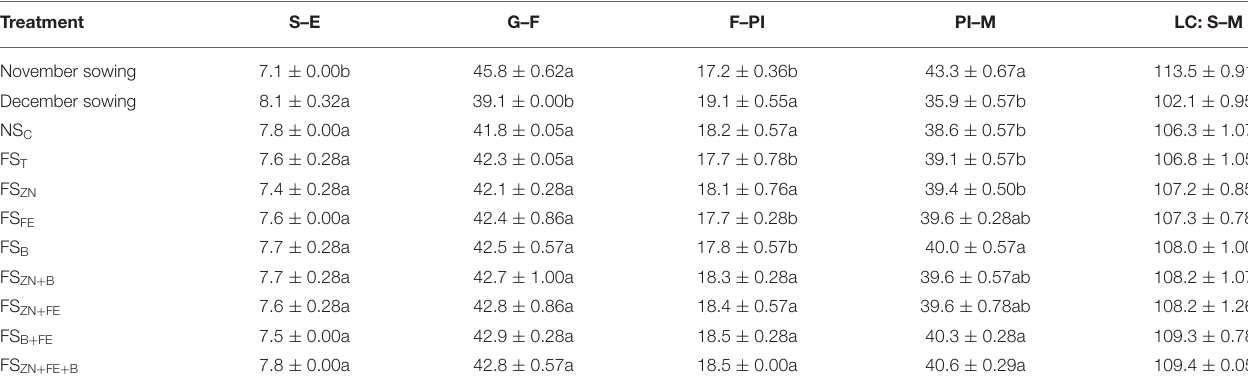
TABLE 5 | Phenology of lentil influenced by date of sowing and foliar sprayof micronutrients (pooled data of 2 years).